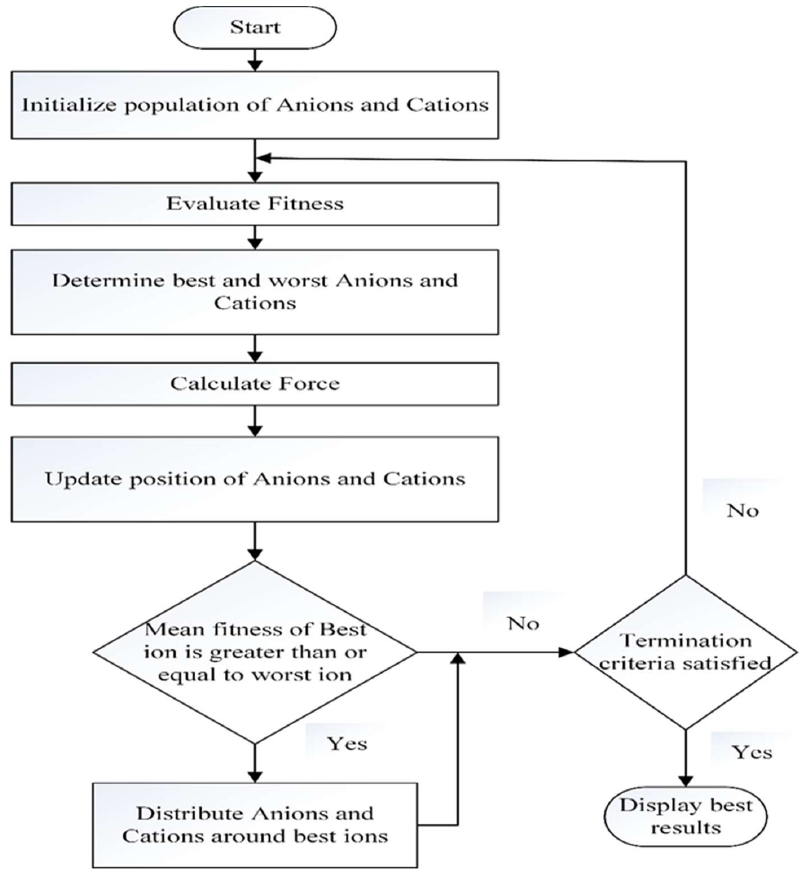
Fig. 3 . Standard procedure of